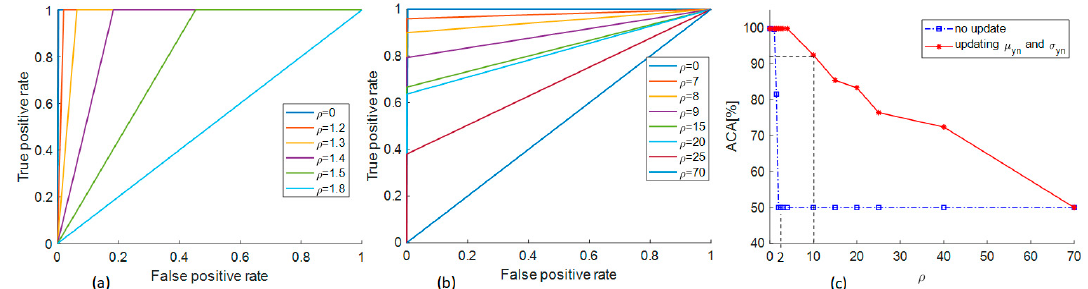
Figure 12. ROC and ACA according to ρ : ( a ) ROC without updating µ yn and σ yn , ( b ) ROC with updating µ yn and σ yn , ( c ) ACA reduction.